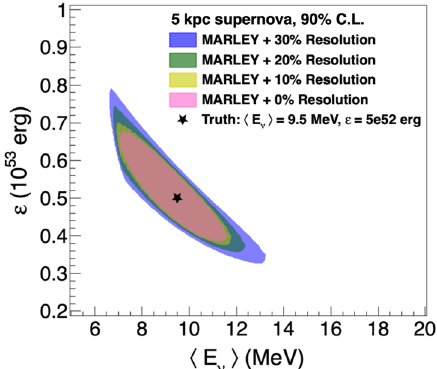
Fig. 17 90% C.L. contours for the luminosity and average ν e energy spectral parameters for a supernova at 5 kpc. The contours are obtained usingthetime-integratedspectrum.Asdiscussedinthetext,theallowed regions change noticeably but not drastically as one moves from no detector smearing (pink) to various realistic resolutions (wider